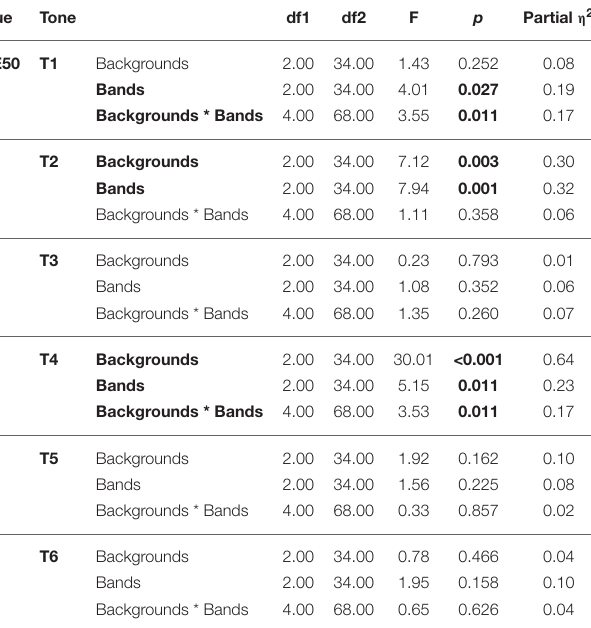
TABLE 9 | Results of Tone * Bands * Backgrounds three-way repeated measures ANOVA on tone accuracy by Cues. Cue df1 df2 F p Partial η 2 ORI Backgrounds 2.00